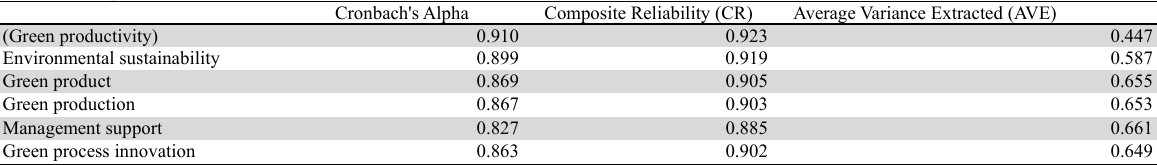
Results of Convergent Validity and Reliability Analysis Using Confirmatory Factor Analysis (CFA) Composite (CR) And Cronbach Alpha